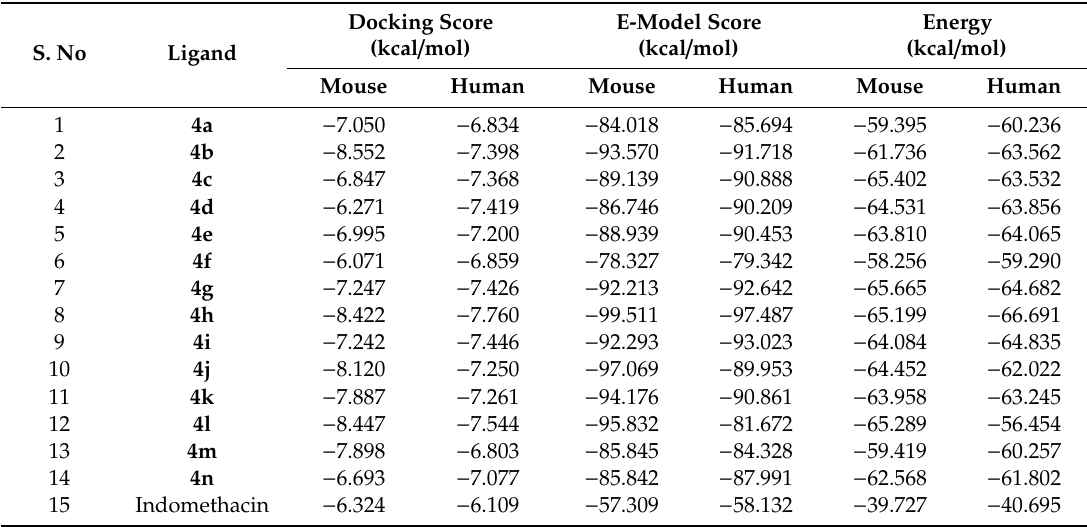
Table 5. Summary of molecular docking score of di ff erent ligands against Cox-2 (target protein) from mouse (3NT1) and human